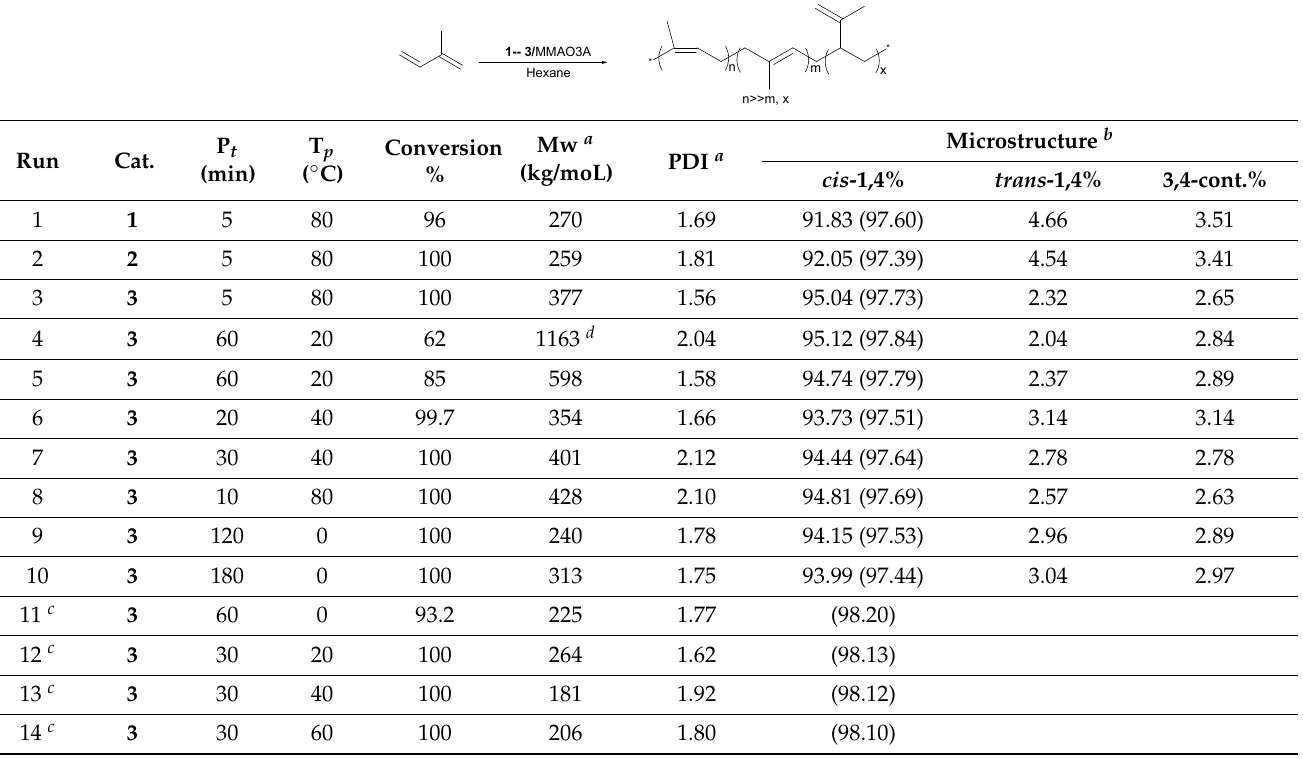
Table 2. Polymerization of isoprene (IP) with complexes 1 – 3 and MMAO3A catalyst systems.